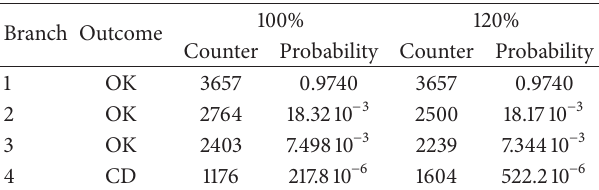
Table 5: Summary of the statistical analysis for 100% and 120% power